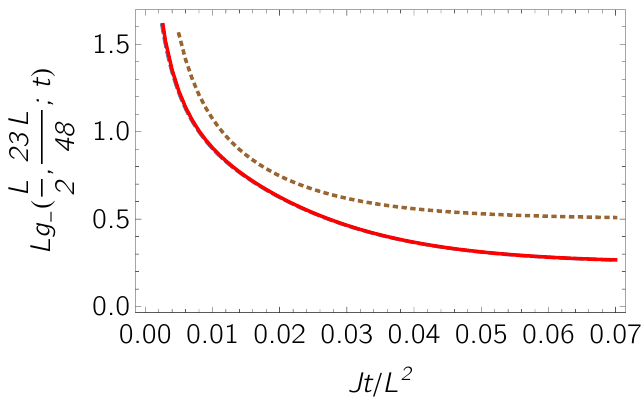
Figure 8: Comparison between g − ( L / 2,23 L / 48; t ) as a function of J t / L 2 on a ring of L = 96 (blue dashed) sites with domain wall initial conditions and G (red solid). The dotted drown line is the result for G ( x , y ; t ) only.